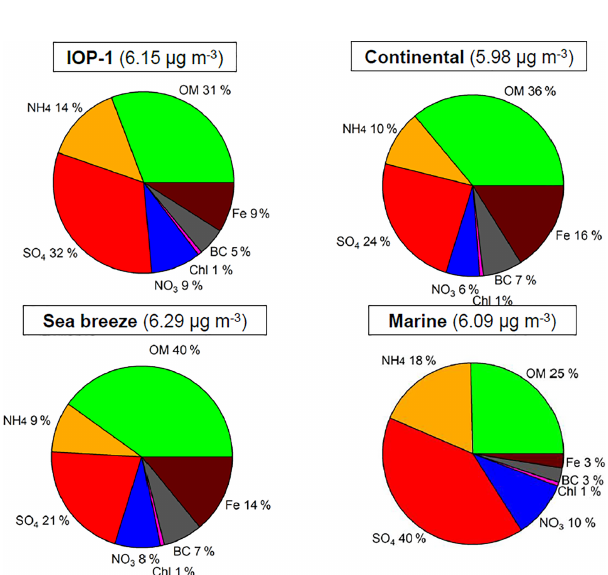
Figure 5. Averaged contributions of NR PM 1 , BC and Fe for IOP-1 ( n = 3771), continental ( n = 307), sea breeze ( n = 799) and marine days ( n = 1843), with average total concentration in micrograms per cubic meter (µgm − 3 ) in